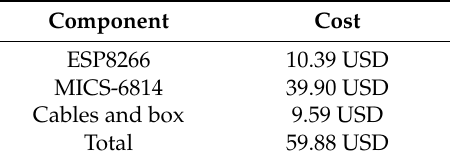
Table 2. Cost of the iAir system.